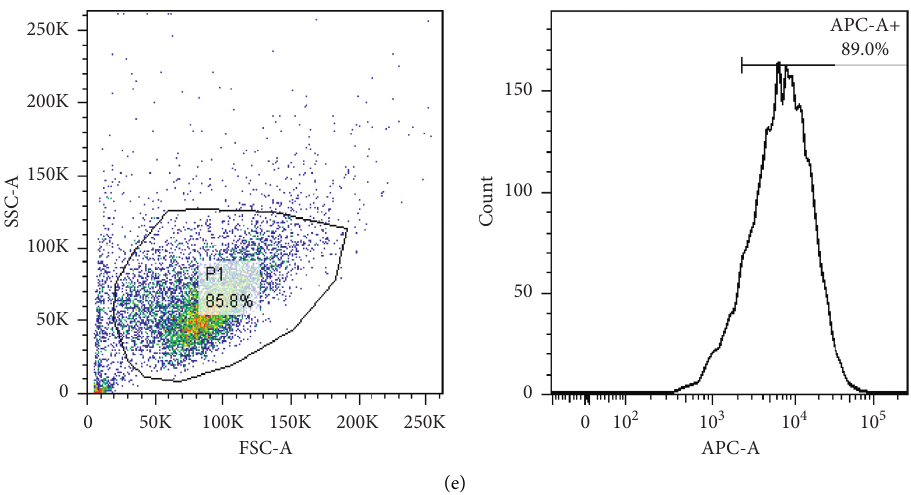
Figure 5: The transfection efficiency of different concentrations of siRNA in CM cells (APC-A+ indicates the number of cells labeled with Cy5). (a) Transfection of 10nM Cy5-NC-siRNA control group. (b) Transfection reagent +10nM Cy5-NC-siRNA group. (c) Transfection reagent +20nM Cy5-NC-siRNA group. (d) Transfection reagent +50nM Cy5-NC-siRNA group. (e) Transfection reagent +100nM Cy5- NC-siRNA group. The higher the transfection concentration was, the more cells were labeled with Cy5, the higher the transfection efficiency